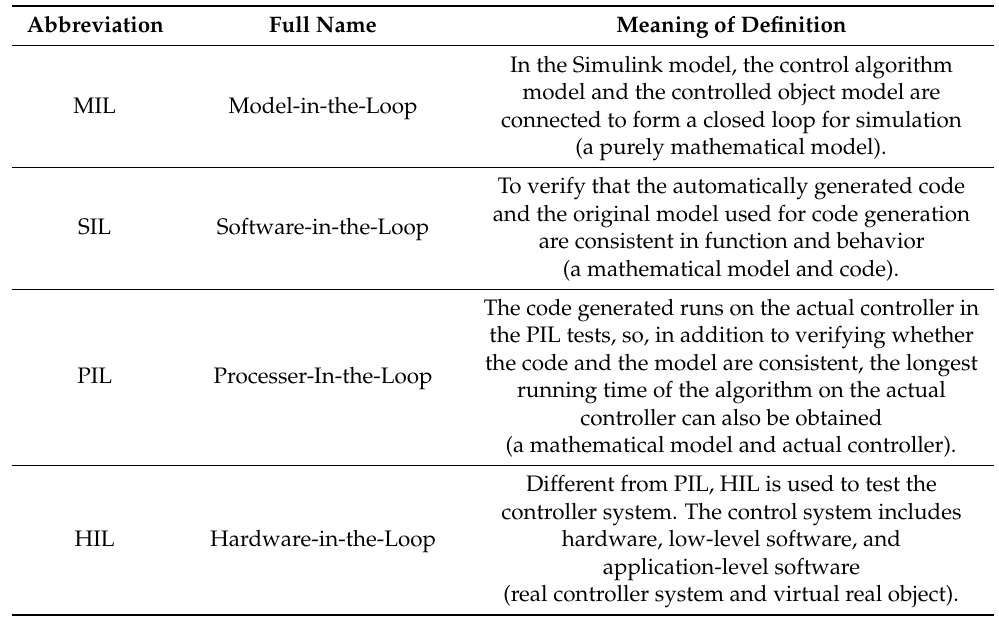
Table 1. The four test methods and their